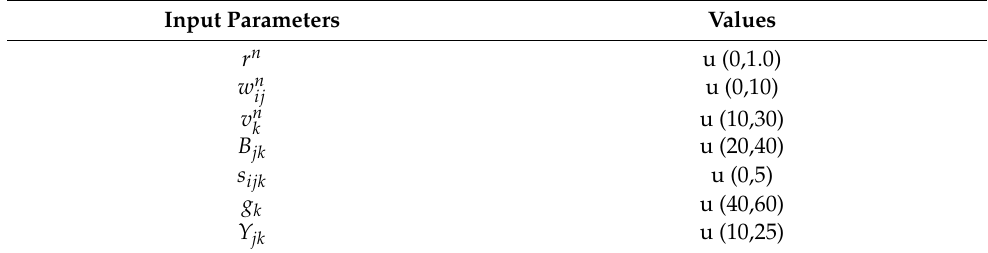
Table 4. Cases for the change in the number of transport companies (forwarders).